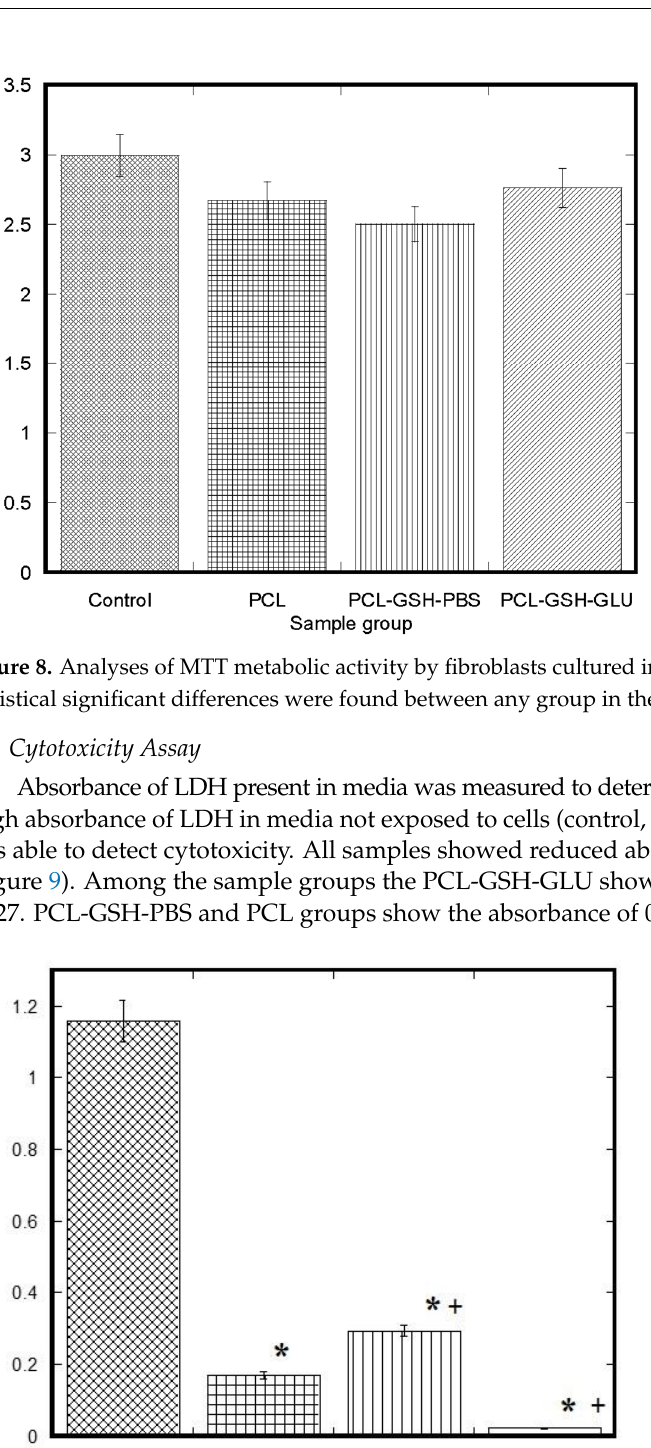
( c ) Figure 7. Cell proliferation as demonstrated by labeled nuclei of ( a ) PCL (Control), ( b ) PCL-GSH- GLU and ( c ) PCL-GSH-PBS. The value in the scale bar is 500 µm.